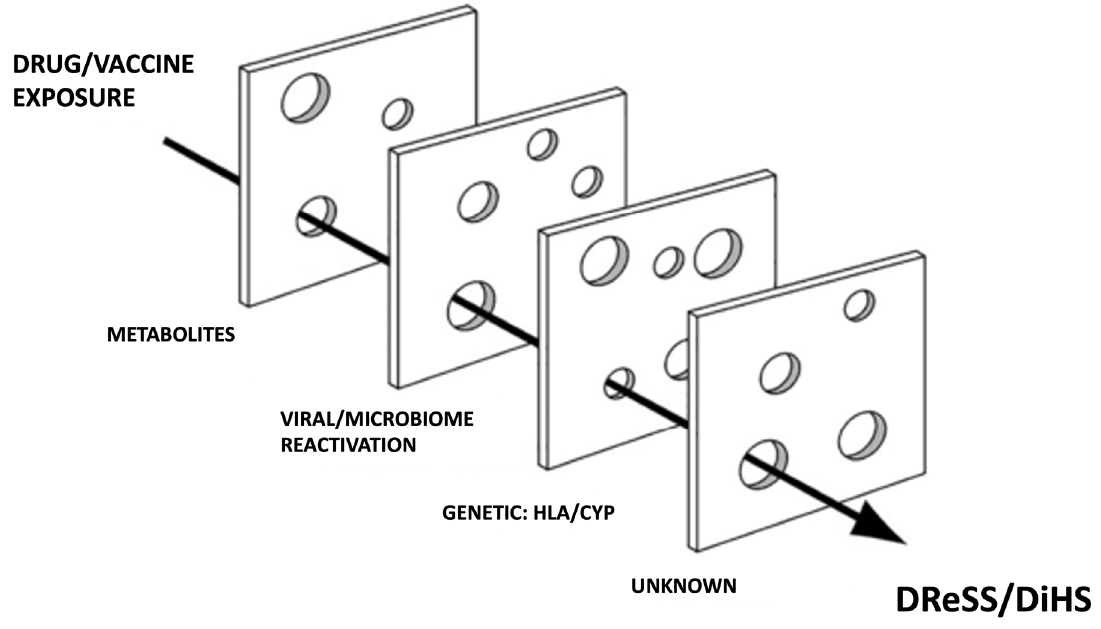
Figure 1. “Swiss cheese” risk model of DReSS/DiHS. CYP cytochrome P450, HLA human leukocyte antigen, DReSS drug reaction with eosinophilia and systemic symptoms, DiHS drug induced hypersensitivity syndrome.